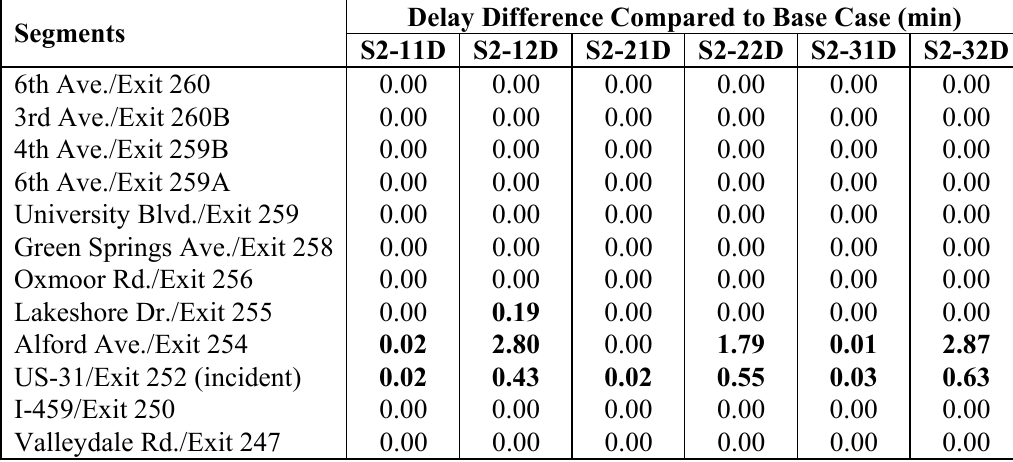
Table 10. Comparison of delay results with information provision